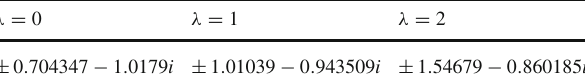
Table 6 The QNMs w = ω r h ( r h = 10 . 6266 ) of dRGT black string with M = 1 ,α g = 1 ,(cid:14) = 0 ,(cid:15) = − 0 . 01 ,γ = 0 , k = 0 , m = 0 . 2 ,λ